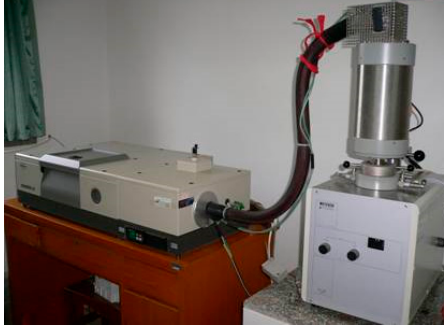
Figure 1. The thermo-gravimetric analyzer.